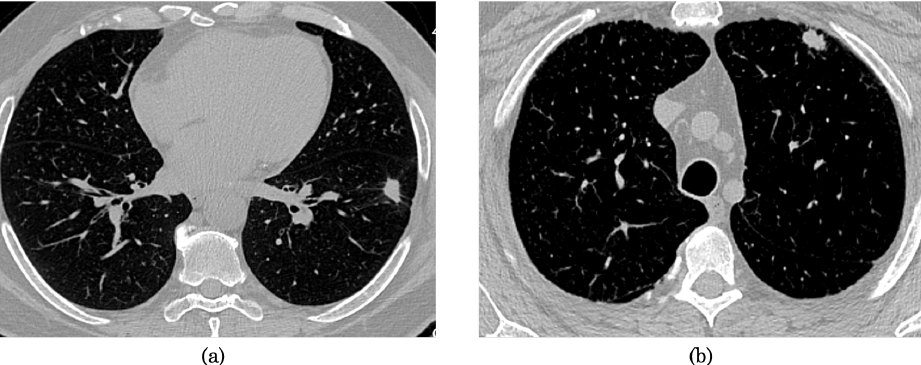
Figure 2. Representation of lung axial slices with nodule from the NSCLC-Radiogenomics dataset of patients with ( a ) mutant EGFR and ( b ) wild-type EGFR